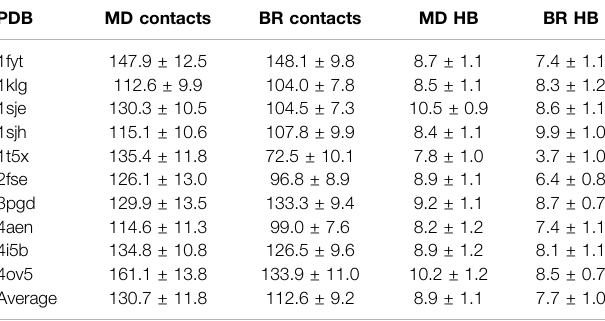
TABLE 2 | Average and fractional error of the number of contacts and hydrogen bonds (HB) made by the main chain atoms of the peptide-core amino acids bound toMHCclass II,and sampledwith MDor backrub (BR) using kT (cid:1) 1 . 2.The fractional error was calculated using the standard deviation from the simulations for each peptide core position. The last row shows an average value for all the